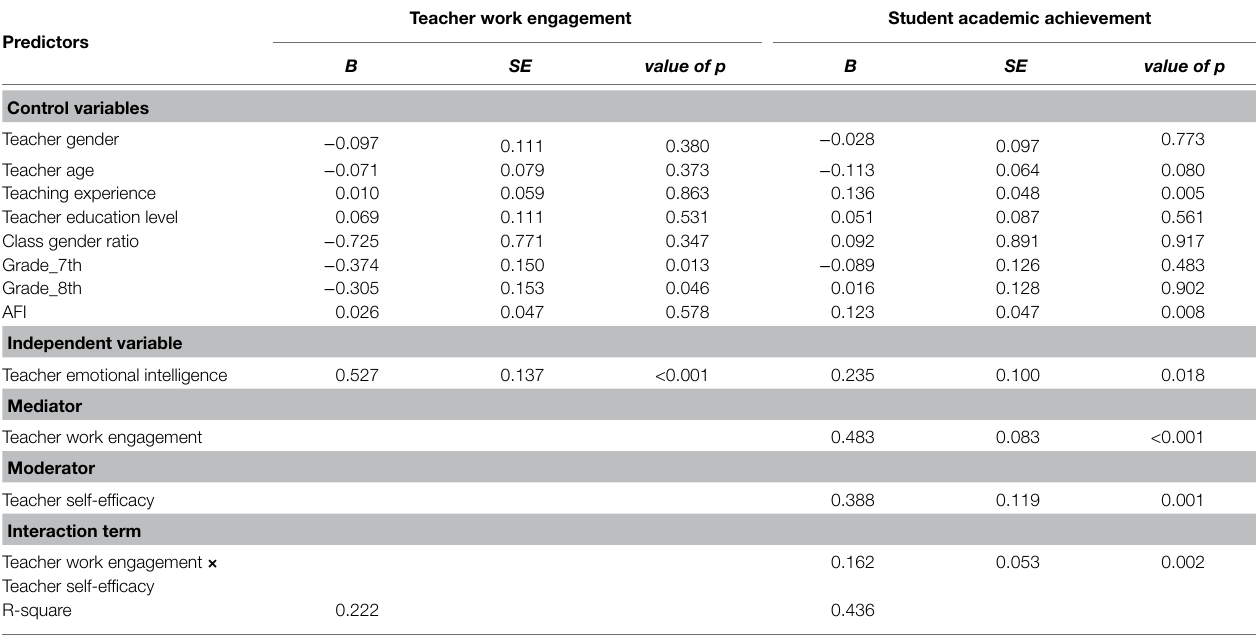
TABLE 4 | Mediating effect of teacher work engagement moderated by teacher